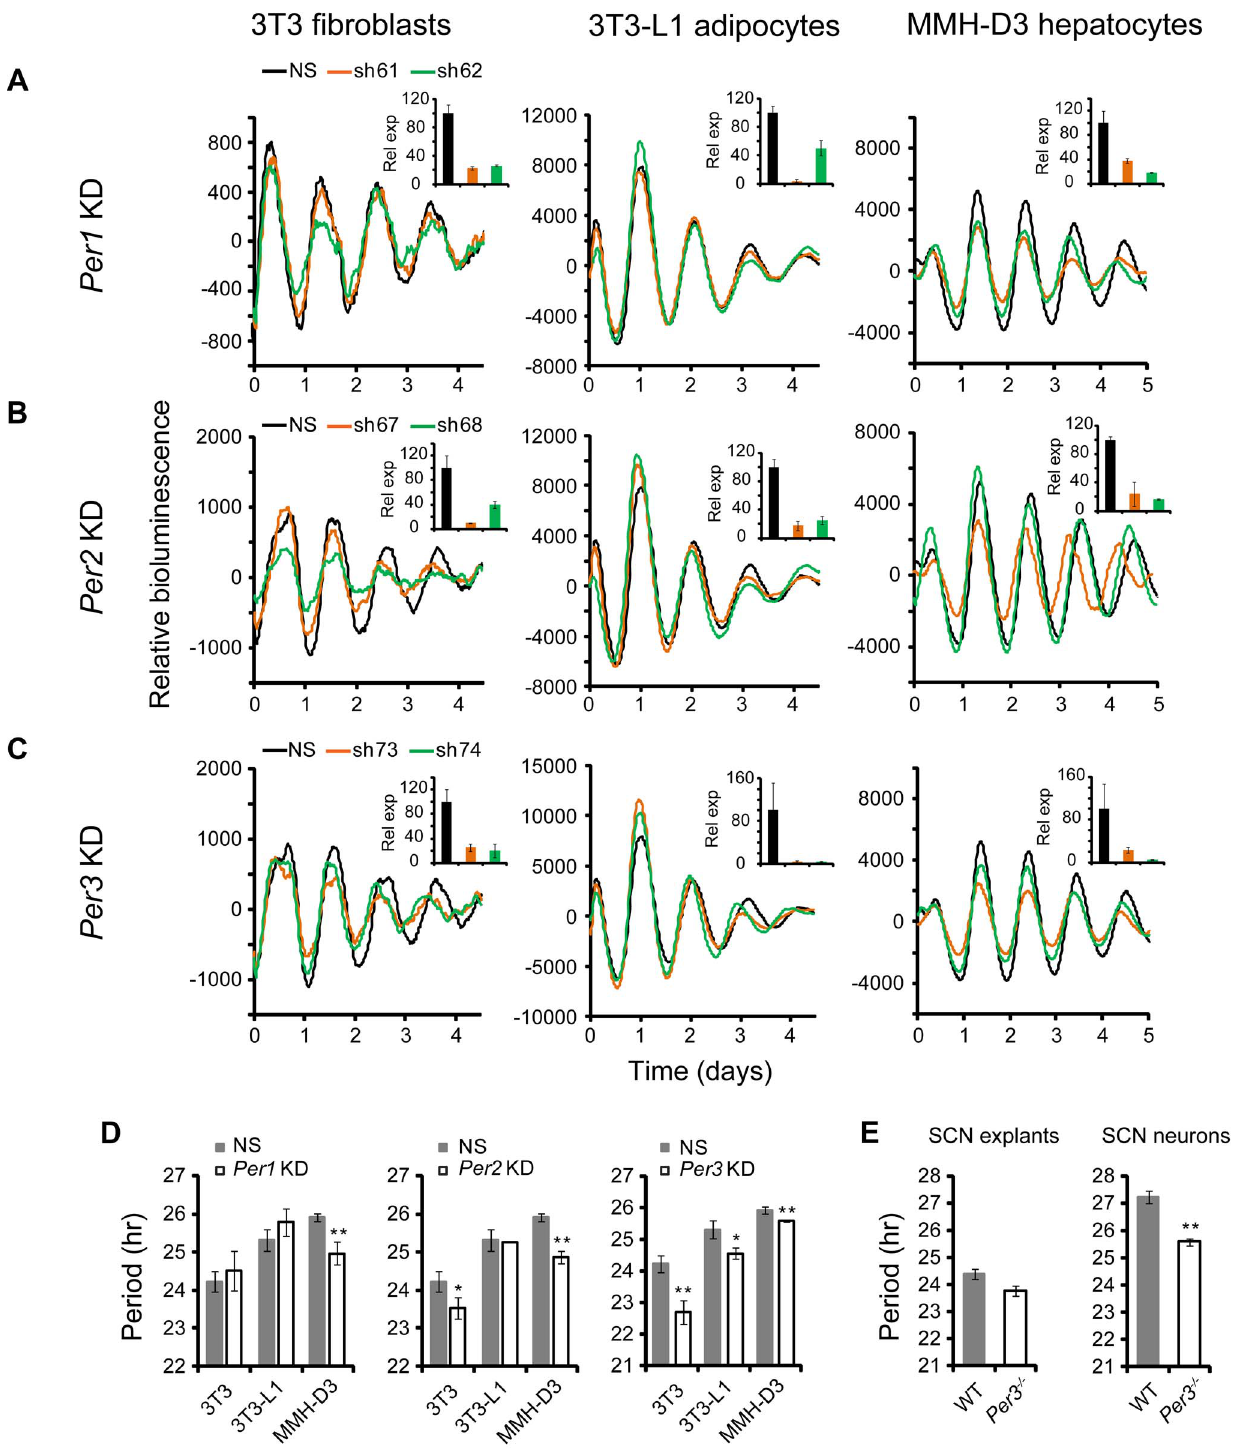
Figure 4. shRNA-mediated knockdowns of Per1 , Per2 and Per3 lead to cell type-specific circadian phenotypes. Bioluminescence expression patterns upon KD of Per1 (A), Per2 (B), and Per3 (C) in all three cell types. See Figure 2 for details. Whereas Per3 KD led to short periods in all three cell types, Per1 and Per2 KDs caused different clock phenotypes depending on cell type. (D) Summary of period length phenotypes. Data are mean 6 SD (n=4 independent experiments for 3T3 cells; n=3 samples/wells of one experiment for 3T3-L1 and MMH-D3 cells). NS, non-specific shRNA. Compared to NS controls, significant difference in period length was detected in the following KDs: NS vs. Per1 KD in MMH-D3, t-test, p , 0.001; NS vs. Per2 KD in 3T3, t-test, p=0.013; NS vs. Per2 KD in MMH-D3, t-test, p , 0.001; NS vs. Per3 KD in 3T3, t-test, p , 0.001; NS vs. Per3 KD in 3T3-L1, t-test, p=0.003; NS vs. Per3 KD in MMH-D3, t-test, p , 0.001). *p , 0.01; ** p , 0.001. (E) Per3 deletion led to short period length defects in SCN explants (left) and even stronger defects in dissociated SCN neurons (right). Per3 2 / 2 SCN explants show a slightly shorter period than WT (mean 6 SEM: WT, 24.4 hr 6 0.17, n=5; Per3 2 / 2 , 23.78 hr 6 0.18, n=5). The mean period of rhythms in Per3 2 / 2 neurons was substantially shorter than in WT